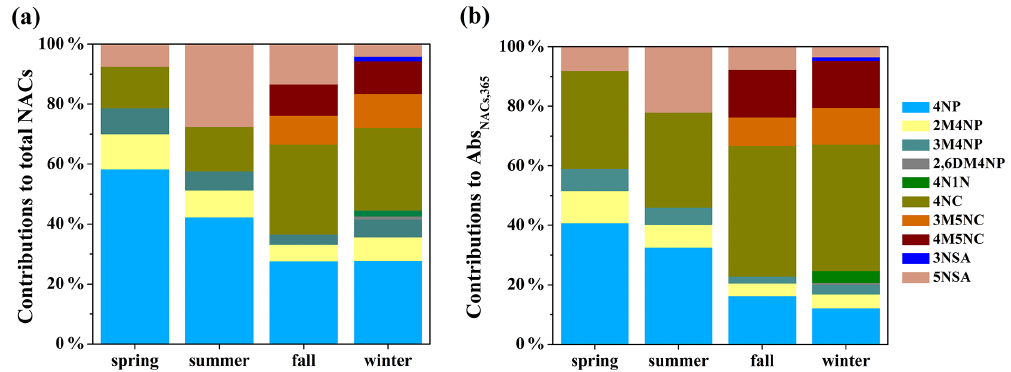
Figure 3. Average contributions of individual nitrated aromatic compounds to (a) the total concentration and (b) the total light absorption at a wavelength of 365nm of particulate nitrated aromatic compounds in four seasons. The full names of the compounds are given in Table